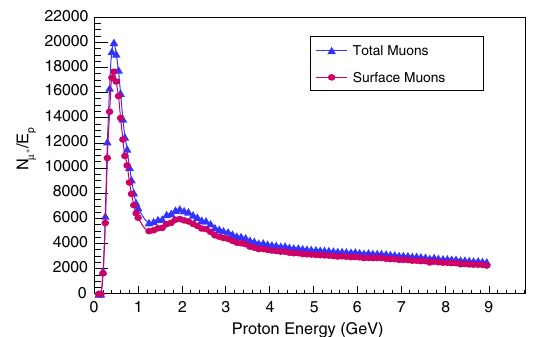
FIG. 15. Normalization of the muon yield to the proton energy.